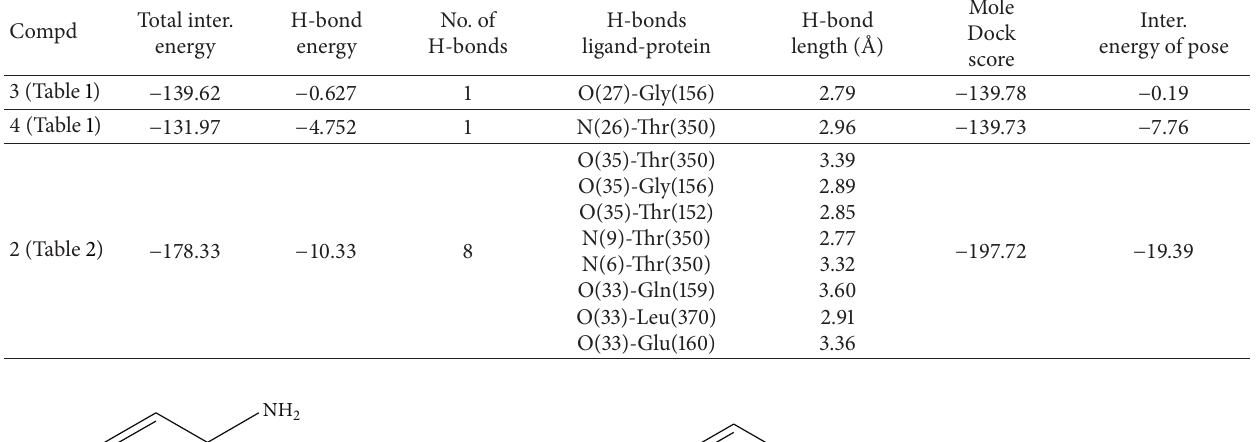
Table 5: Docking results of a training set compound (3), a test set compound (4) of Table 1, and a predicted compound (2) for comparison. Energy values are in